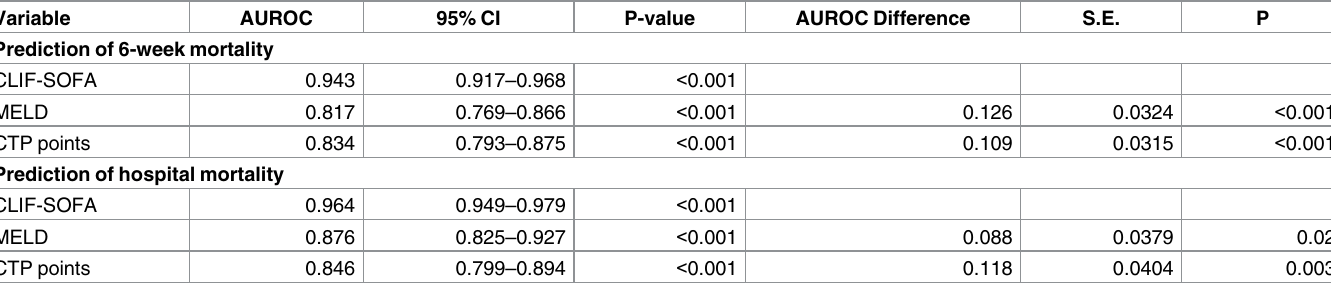
Table 3 revealed the cut-off point in manner of Youden index for CLIF-SOFA score, MELD score, and CTP points. The sensitivity, specificity, positive predictive values, negative predic- tive values, and accuracy were also shown at the best cut-off point. For CLIF-SOFA score, we identified the cut-off point of 6.5 for not only hospital but also 6-week mortality. Since the history of hepatocellular carcinoma was one of important risk factors for 6-week mortality, we made further subgroup ROC analysis depends on with or without a history of hepatocellular carcinoma in Table 4. In order to predict 6-week mortality, the cut-off point was 6.5 for patients with hepatocellu- lar carcinoma. The result was similar with all patients. However, the cut-off point was changed to 5.5 for patients without hepatocellular carcinoma.